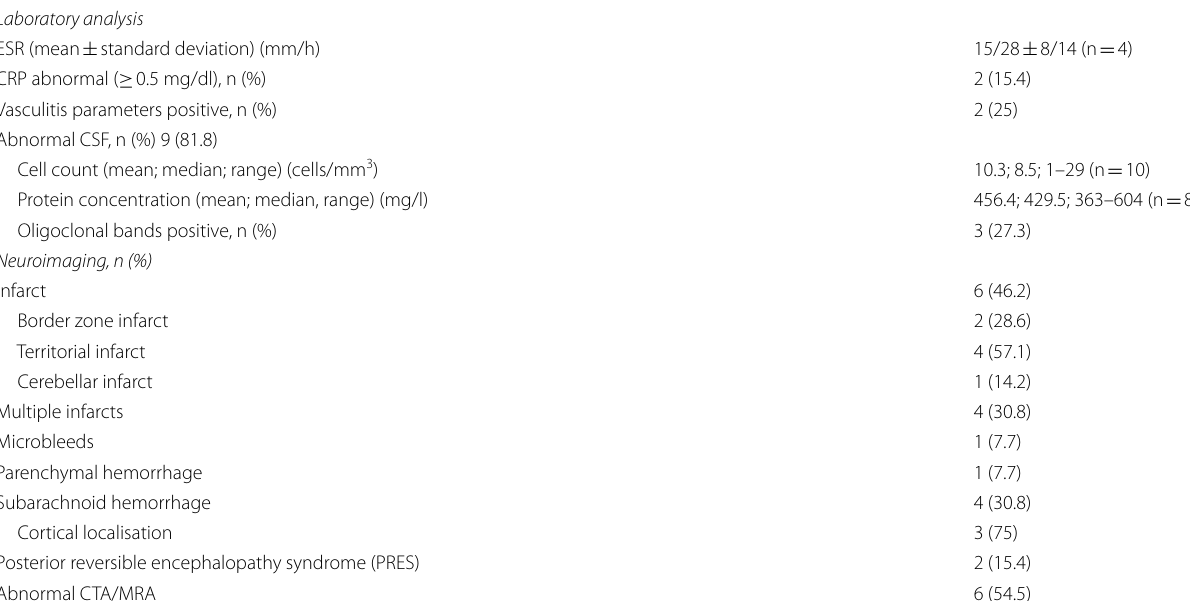
Table 4 Laboratory and